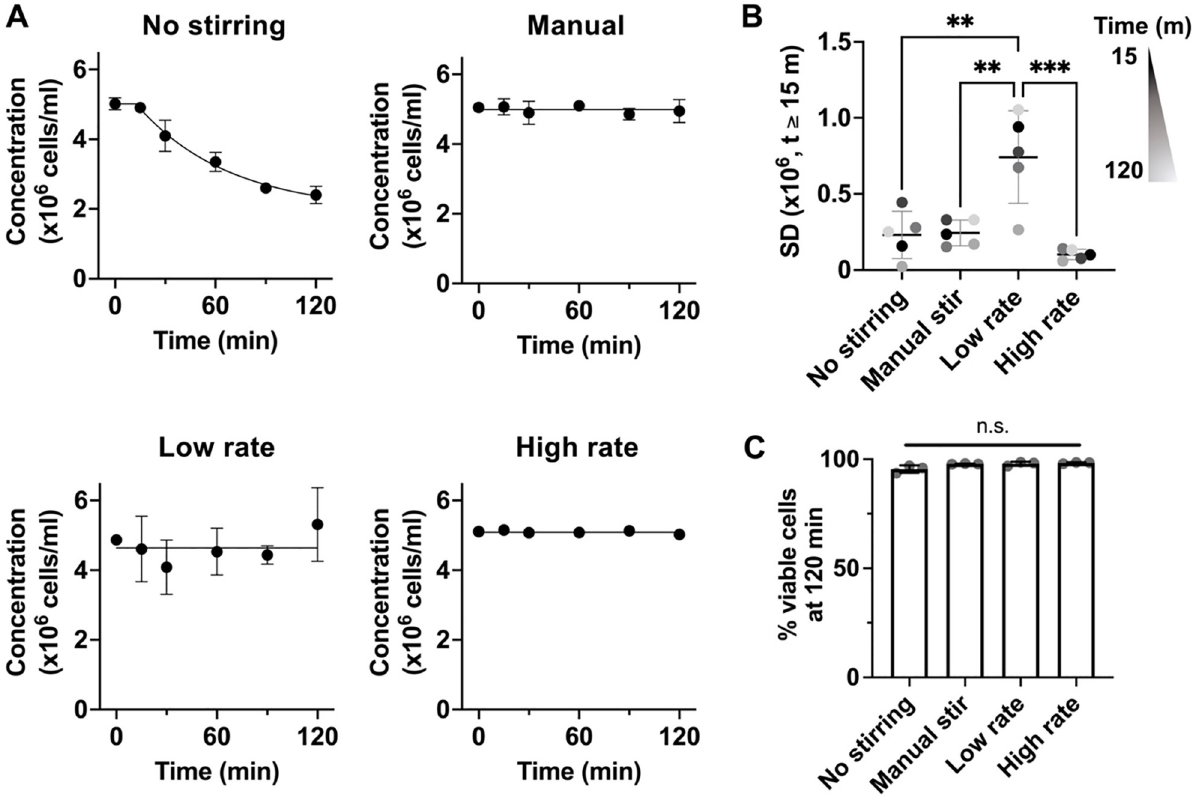
Fig 3. Automated stirring maintains cell concentration over time and cell viability. (A) Cell concentrations as a function of time for each agitation condition. The data were fitted to a constant followed by one-phase exponential decay curve for no stirring (t 0 =12.4 min, t 1/2 =38.7 min, plateau after decay = 1.92 million; R 2 > 0.95), and a linear curve with slope = 0 for other groups. P < 0.05 via two-way ANOVA. (B) Standard deviation of cell concentrations for each agitation condition. ��� p < 0.001, �� p < 0.01 via one-way ANOVA followed by Tukey’s multiple comparisons test. (C) Percentage of viable cells at 120 minutes of agitation at agitation conditions. n = 3 independent experiments, each performed in two replicates. Error bars represent standard